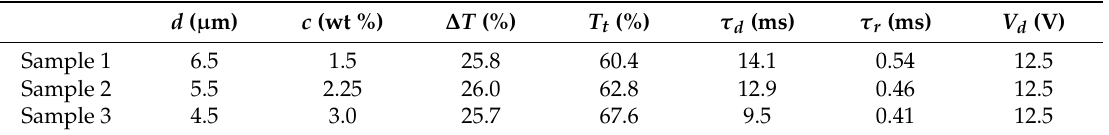
Table 1. The measured transmittance difference ∆ T , transmittance in the transparent state T t , and the decay time τ d , rise time τ r , and driving voltage V d of the fabricated ECB